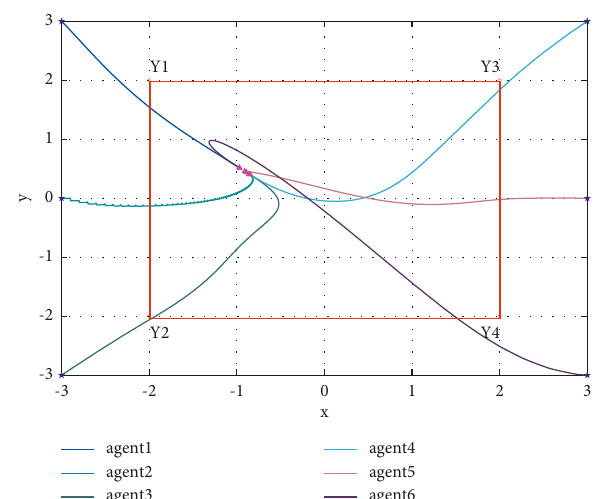
Figure 1: Four directed graphs.